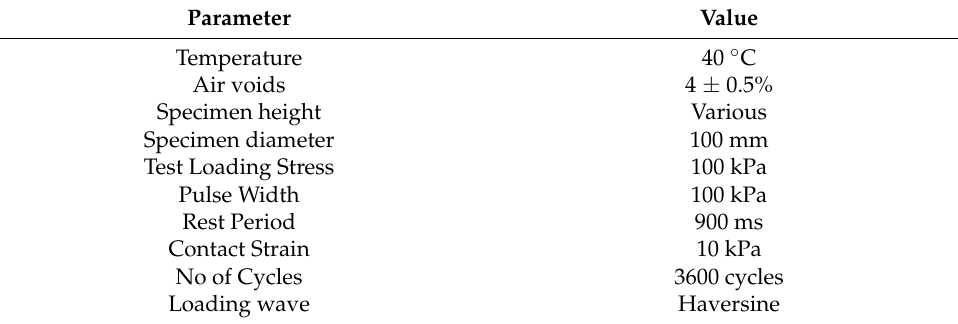
Table 12. Parameters for the dynamic creep test.